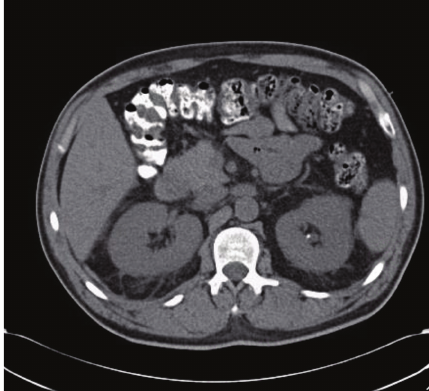
Figure 3: CT of abdomen and pelvis without IV contrast. CT of abdomen and pelvis without IV contrast showing a 3 mm nonobstructing left renal calculus with normal size kidneys and no